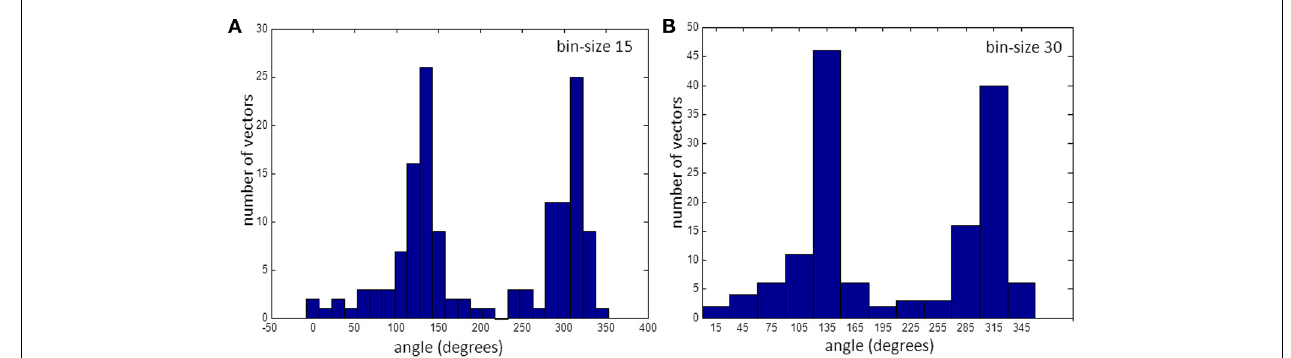
FIGURE 4 | Histogram of vectors in bins. (A) for 15 ◦ bins and (B) for 30 ◦ . Note that the bin at 225 ◦ is empty. (See also gap in Figure 3A ).